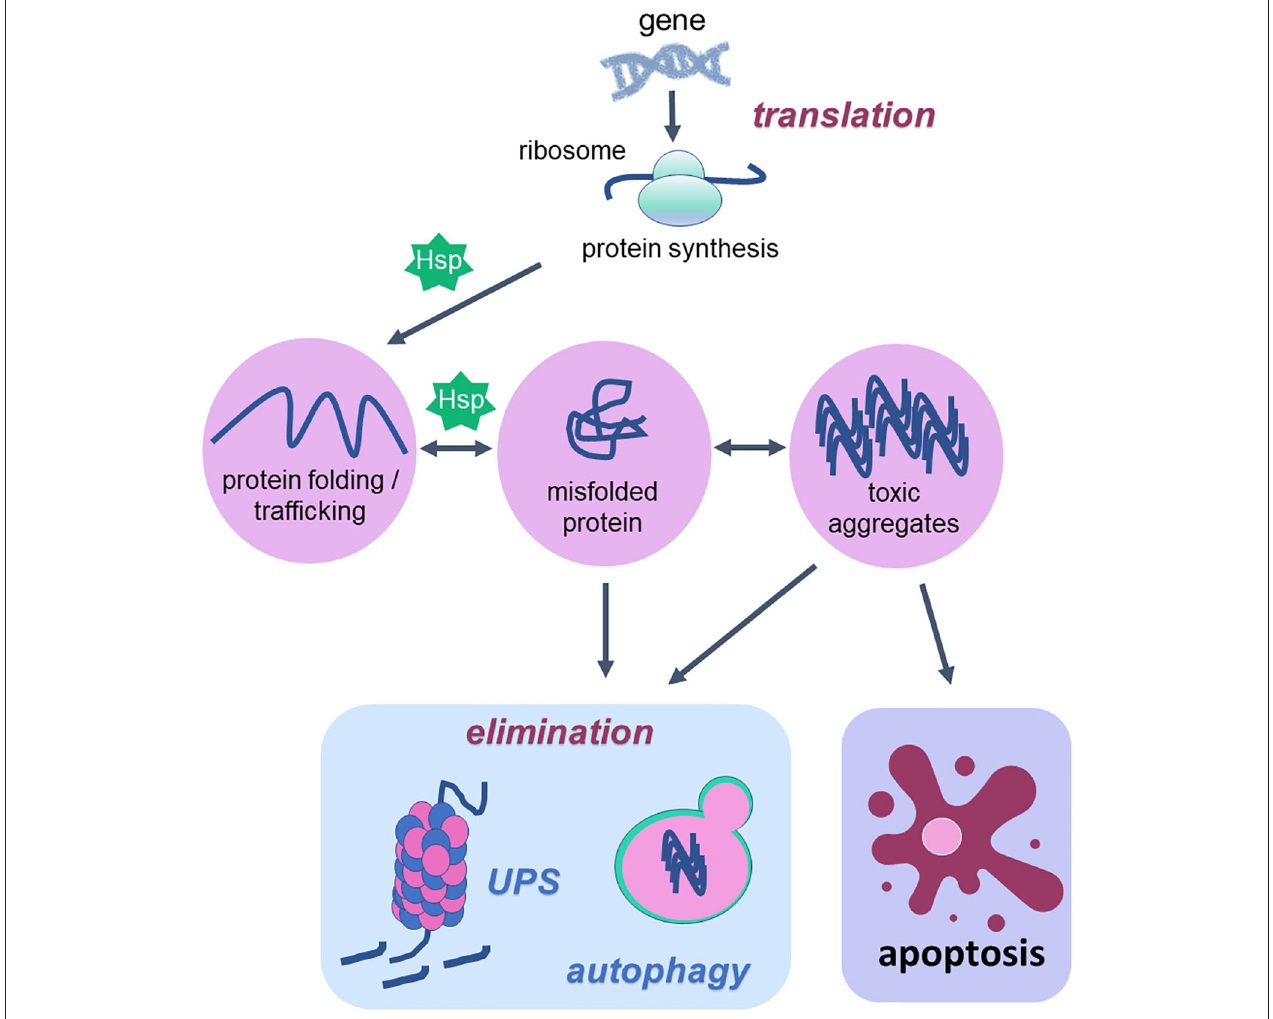
FIGURE 1 | Cellular proteostasis and apoptotic cell death. Proteostasis network is the protein pool quality control system that integrates the pathways related to protein synthesis since translation, protein folding, protein unfolding, secretion, trafficking and degradation or elimination. To succeed in protein folding, unfolding, refolding and trafficking, chaperone proteins (heat shock proteins—Hsp) are of fundamental importance. In the elimination phase that usually happens when misfolded proteins turn into toxic aggregates, degradation of damaged proteins occurs through proteolytic systems: autophagy and ubiquitin-proteasome. The activity of both systems avoids cell death. However, when the proteostatic network cannot avoid protein aggregates accumulation, the cell undergoes apoptosis. Thus, degradation system and apoptosis are both important mechanisms for organism homeostasis due to the elimination of damaged proteins and damaged cells, respectively.